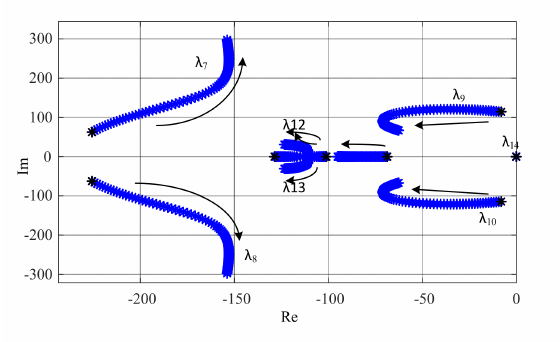
Figure 13. Sensitivity of system eigenvalues with change in k id .